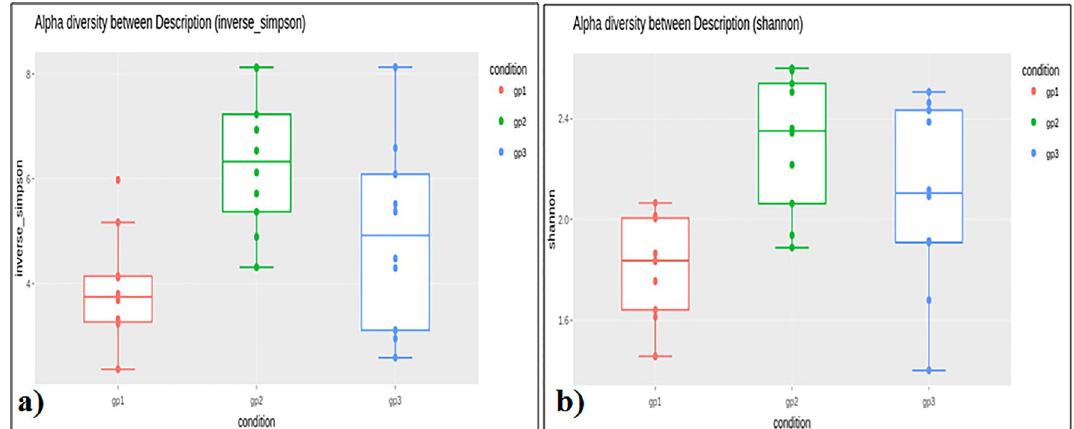
Figure 1. Alpha diversity analysis by using inverse Simpsons diversity indes ( a ) and Shannon index ( b ) (gp1: Adi tribe; gp2: Apatani tribe; gp3: Nyshi